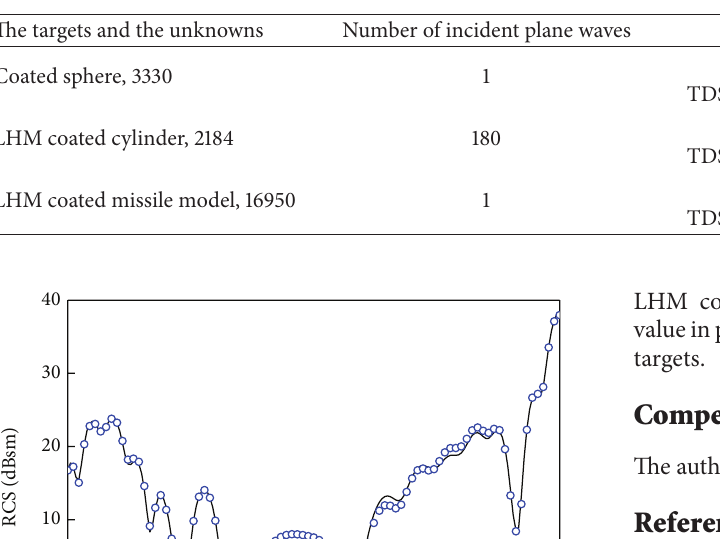
Table 1: Time and RAM requirements.